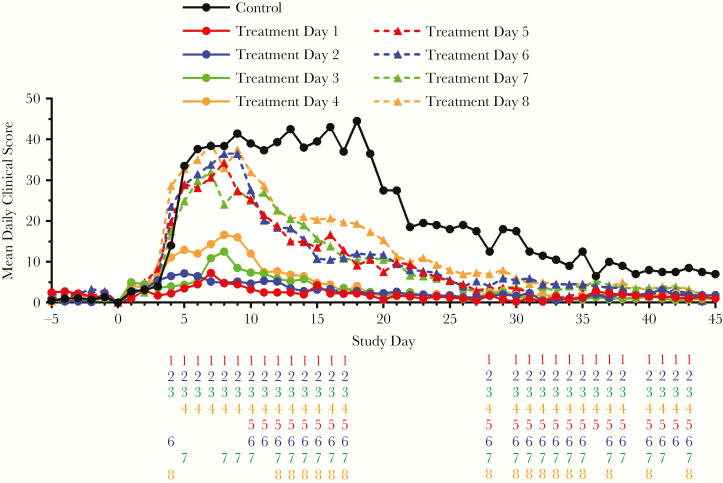
Mean daily clinical observation scores following lethal aerosol challenge with monkeypox virus (MPXV). Detailed clinical observations including temperature, respiratory characteristics, neurological signs, appetite, body weight, appearance, natural cage behavior, provoked (chair) behavior, and gastrointestinal/urogenital characteristics were monitored and documented. Recorded observations were assigned numerical values as indicated below, were compiled into quantitative scores, and the group mean score plotted on each study day. Observations fell into 4 severity categories. Category 1 observations were assigned a value of 1 and included dry cough, mild lethargy, reduced grooming, and thin appearance. Category 2 observations were assigned a value of 2 and included rapid respiration, ataxia, minimal urine output, and sustained piloerection. Category 3 observations were assigned a value of 3 and included dyspnea and extended anorexia, among others. Category 4 observations were assigned a value of 4 and included gasping, hunched or prostrate posture, and unresponsiveness. Results for placebo subjects (solid black line) from day 13 onward represent 2 survivors. Number columns below the x-axis indicate statistically significant differences (determined using analysis of variance; P < .05) in the group mean clinical score between the untreated placebo group and the groups initiating treatment on the indicated day following MPXV challenge (treatment day 1–8). If a number is present, then there was a significant difference between the indicated treatment group and the placebo group. Numbers are color-matched to the treatment groups (treatment days 1 and 5, red; treatment days 2 and 6, blue; treatment days 3 and 7, green; treatment days 4 and 8, orange).